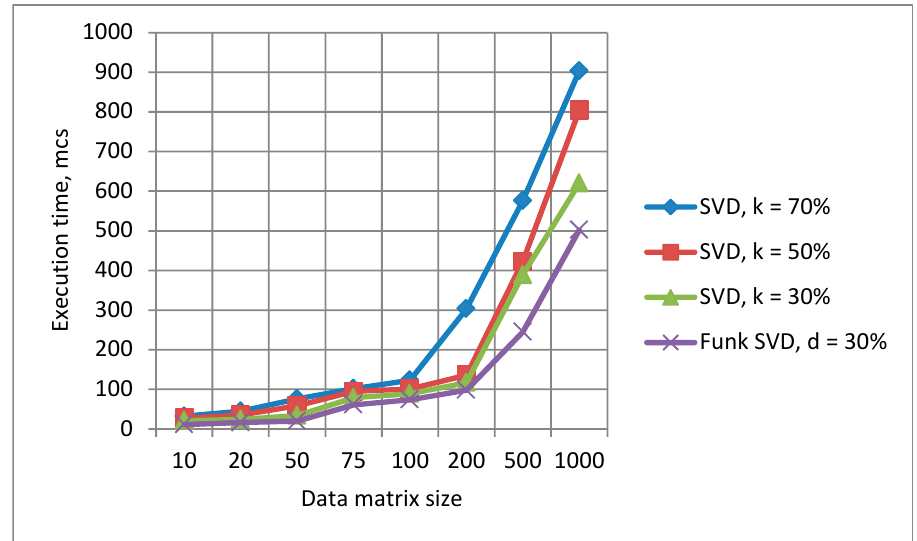
Figure 4. Execution time comparison for the SVD and Funk SVD algorithms.